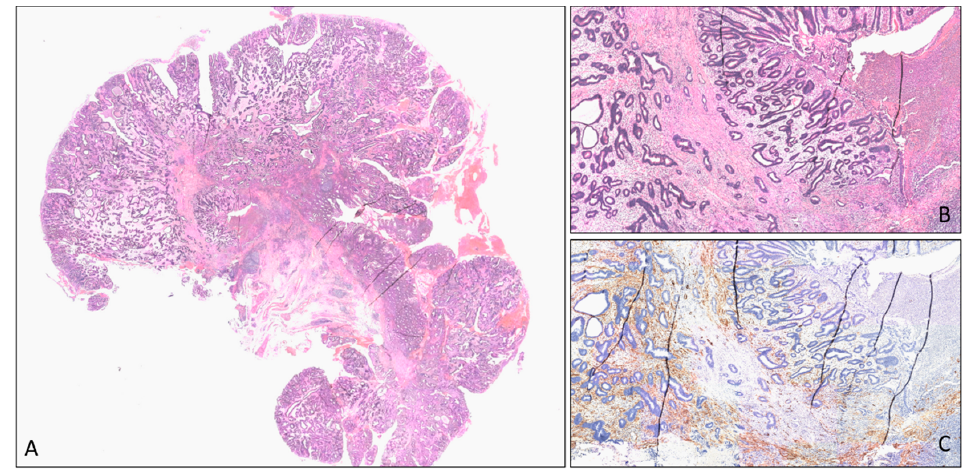
Figure 3. Histologic features of early T1 colorectal carcinoma. ( A ) At low power (Haematoxylin and Eosin, original magnification 10×), the picture shows a malignant sessile polyp. The polypectomy margin is free from neoplasia. At high power (H&E, original magnification 40×), isolated and neoplastic glands invade the upper third of the submucosa (sm1 according to the Kikuchi classification). ( B ) Smooth muscle actin immunohistochemistry stain; ( C ) confirms the presence of glands exceeding the muscolaris mucosae.